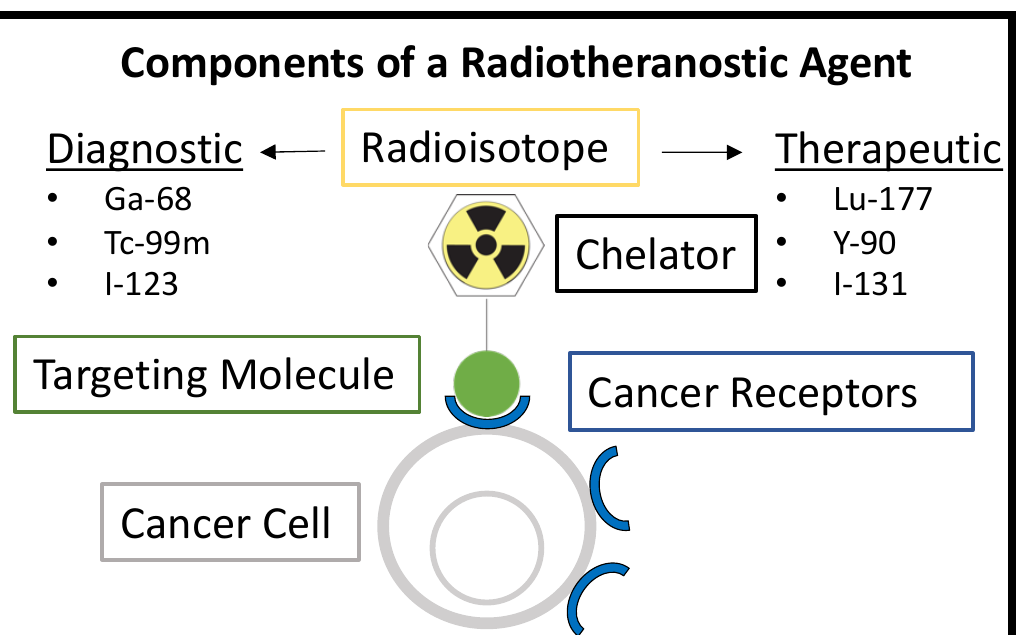
Figure 1. Components of a radiotheranostic, showing the same targeting molecule being used for either diagnostic or therapeutic applications depending on the radioisotope.